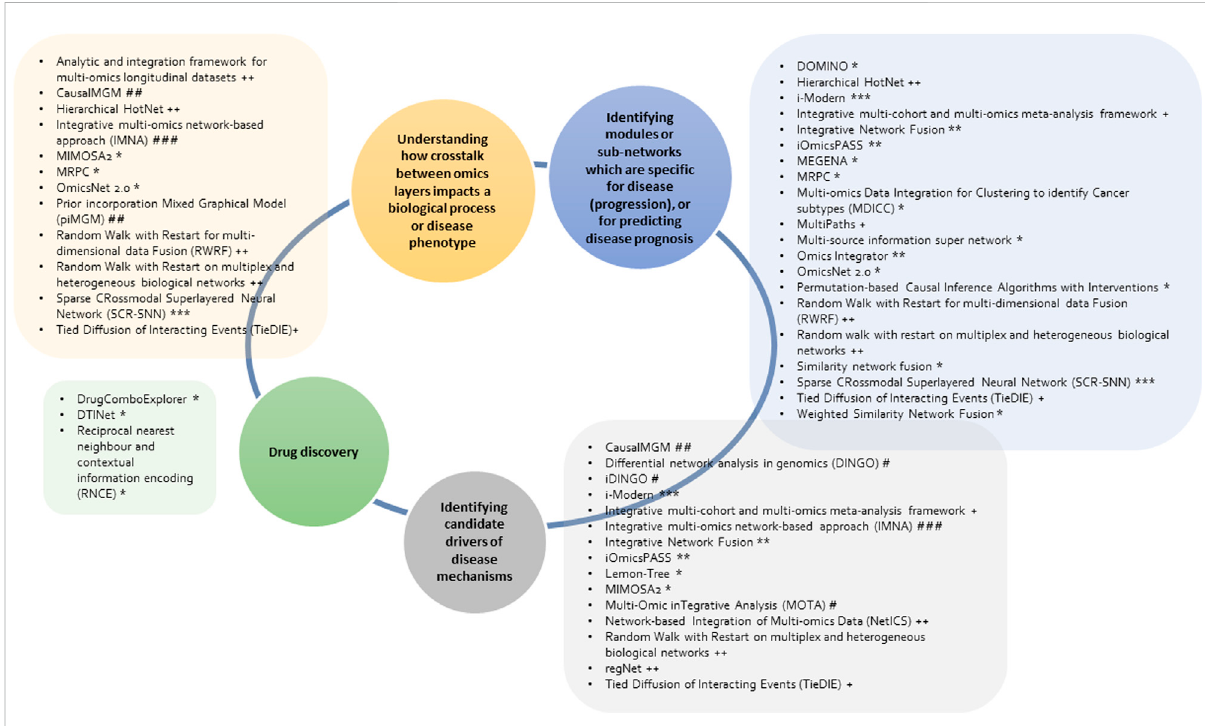
FIGURE 4 Overview of the discussed network-based multi-omics integrative tools and research questions (in the circle) that they can be applied to. The tools implement different methods including unsupervised machine learning (*), supervised machine learning (**), neural networks (***), diffusion- based (+), random walk (++), differential network (#), probabilistic graphical model (##) and Bayesian methods